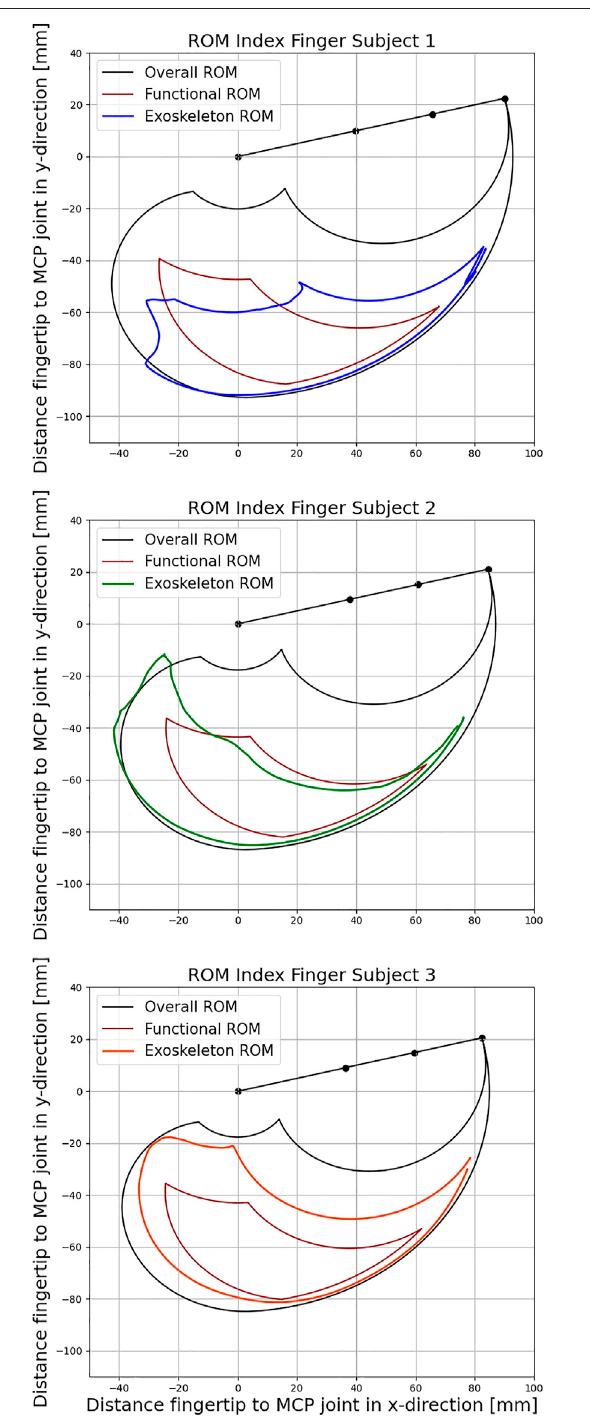
FIGURE 12 | Comparison of the exoskeleton Range of Motion (ROM) with active and functional movement space for the three subjects respectively according to Bain et al.